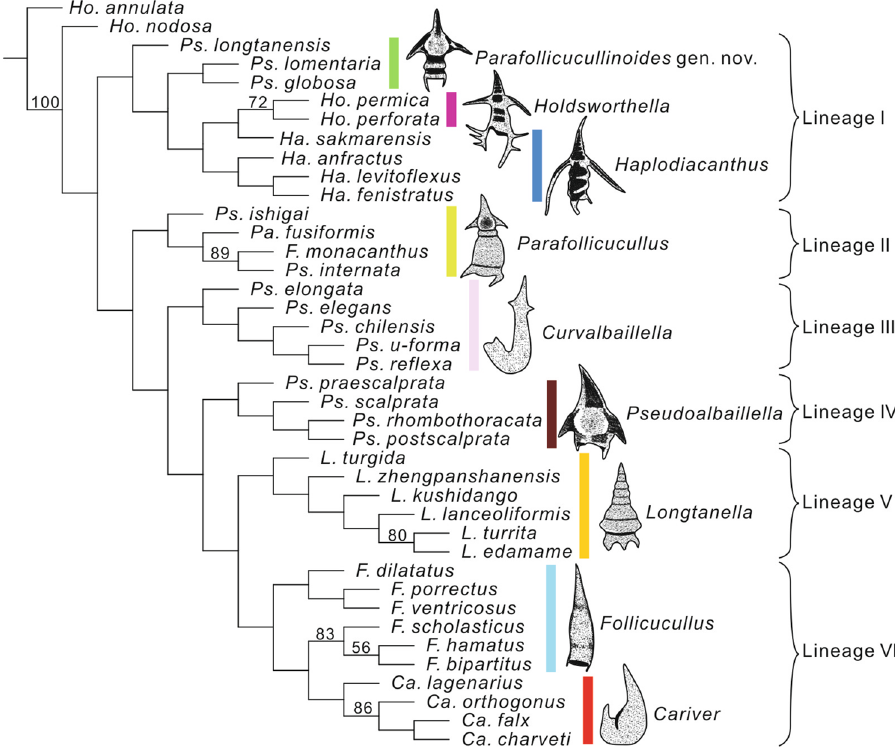
Figure 5. Phylogenetic tree of Follicucullidae obtained by the parsimony analysis (revised after Xiao et al. 11 , the character data set is provided in supplement 6). The species name is written as the original described name. Genus abbreviations: L. , Longtanella ; Pa. , Parafollicucullus ; Ha. , Haplodiacanthus ; Ho. , Holdsworthella ; Ps. , Pseudoalbaillella ; F. , Follicucullus ; Ca. , Cariver . Y.F.X. created this figure using TNT version 1.5 (http:// www. lillo. org. ar/ phylo geny/ tnt/) and CorelDRAW